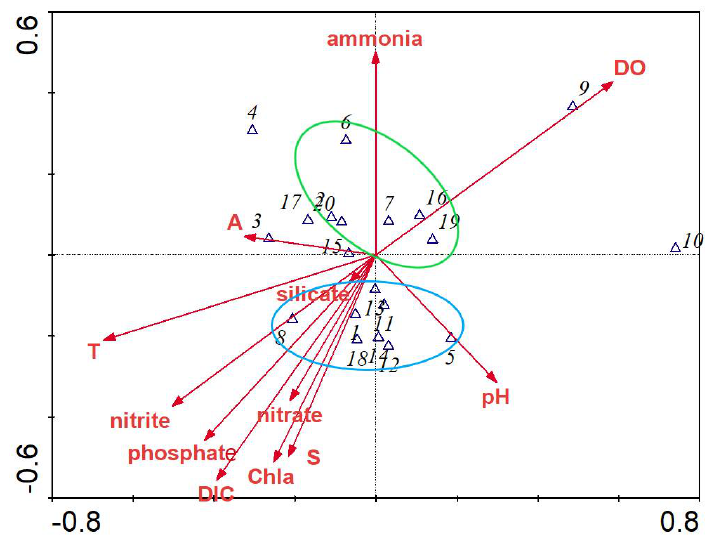
Figure 7. A canonical analysis of biotic and abiotic variables in the survey area. T represents temperature; S represents salinity; A represents total alkalinity; 1–20 are as follows: 1— Acartia negligens , 2— Canthocalanus pauper , 3— Cosmocalanus